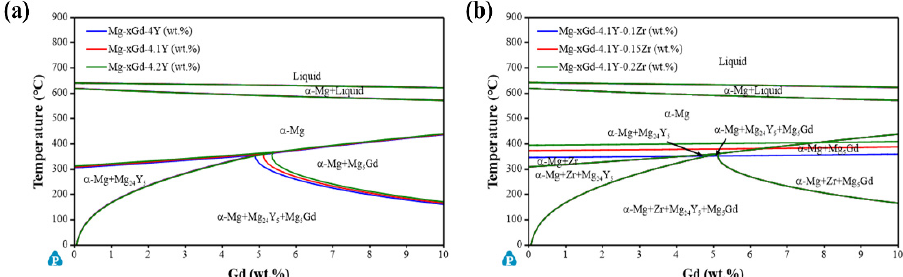
Figure 4. Effect of ( a ) yttrium and ( b ) zirconium on equilibrium phase diagram of the Mg-Gd based alloys.